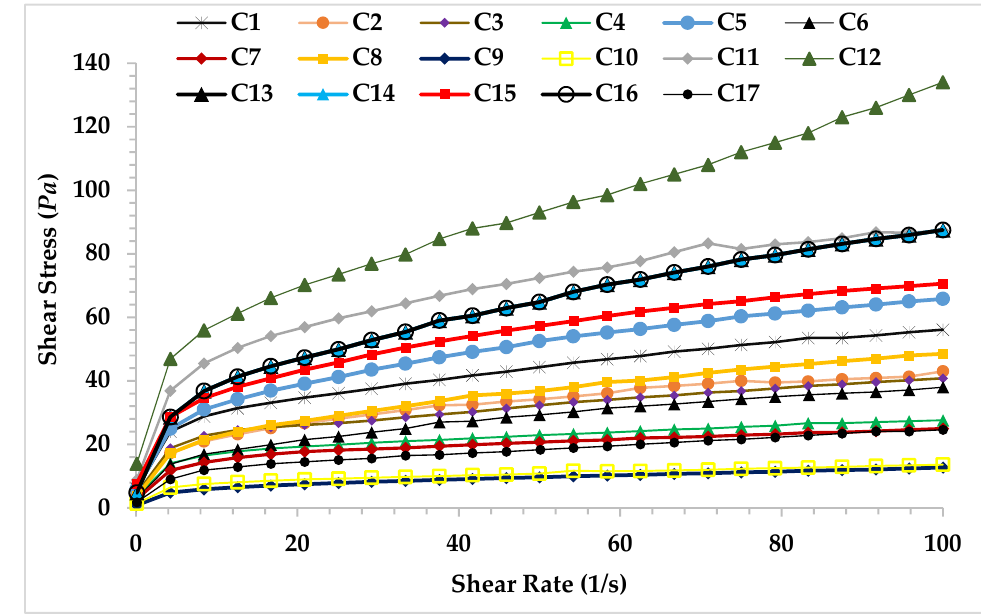
Figure 1. Steady shear rheological behavior of the ice cream mixes. Power law model parameters ( 𝐾 and n values) and determination coefficient ( R 2 ) cal-